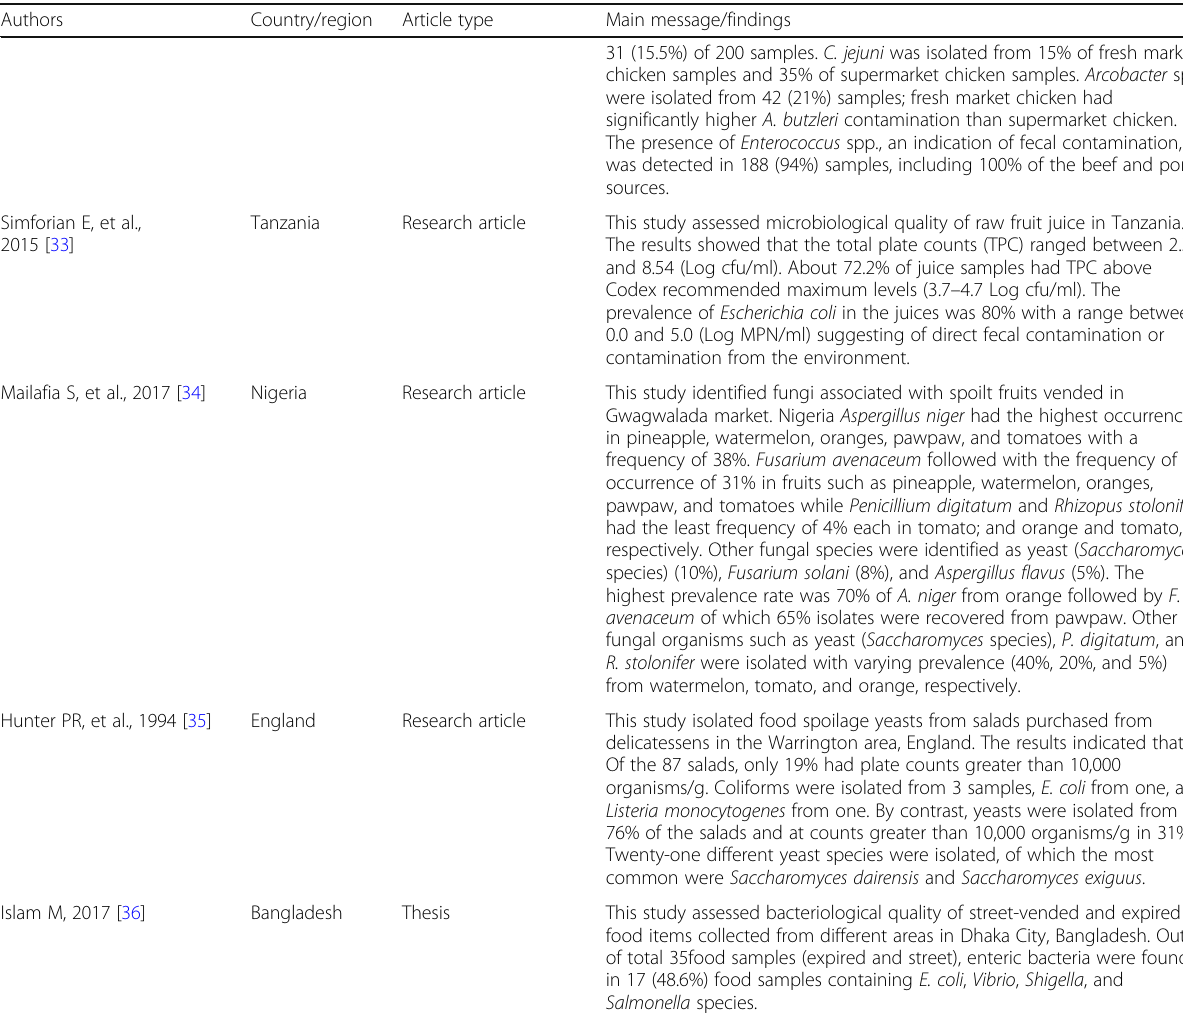
Table 3 Summary of full-text articles which reported microbial contamination of foods as a public risk in food marketing